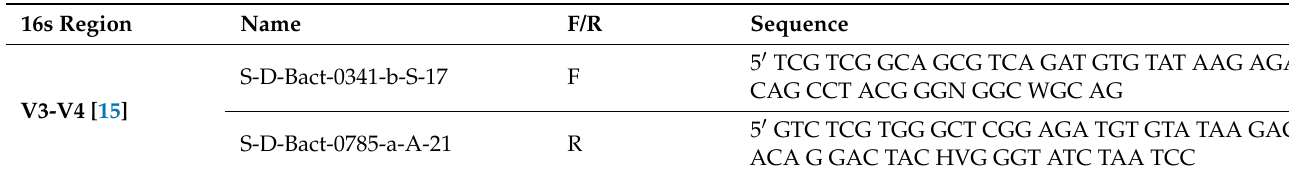
Table 1. Primers used to amplify the V3-V4 regions encoding for the 16 S rRNA for sequencing library